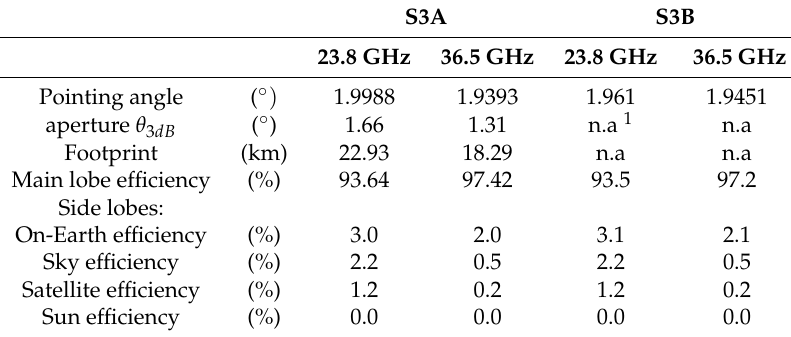
Table 1. Sentinel-3 Microwave Radiometers antenna